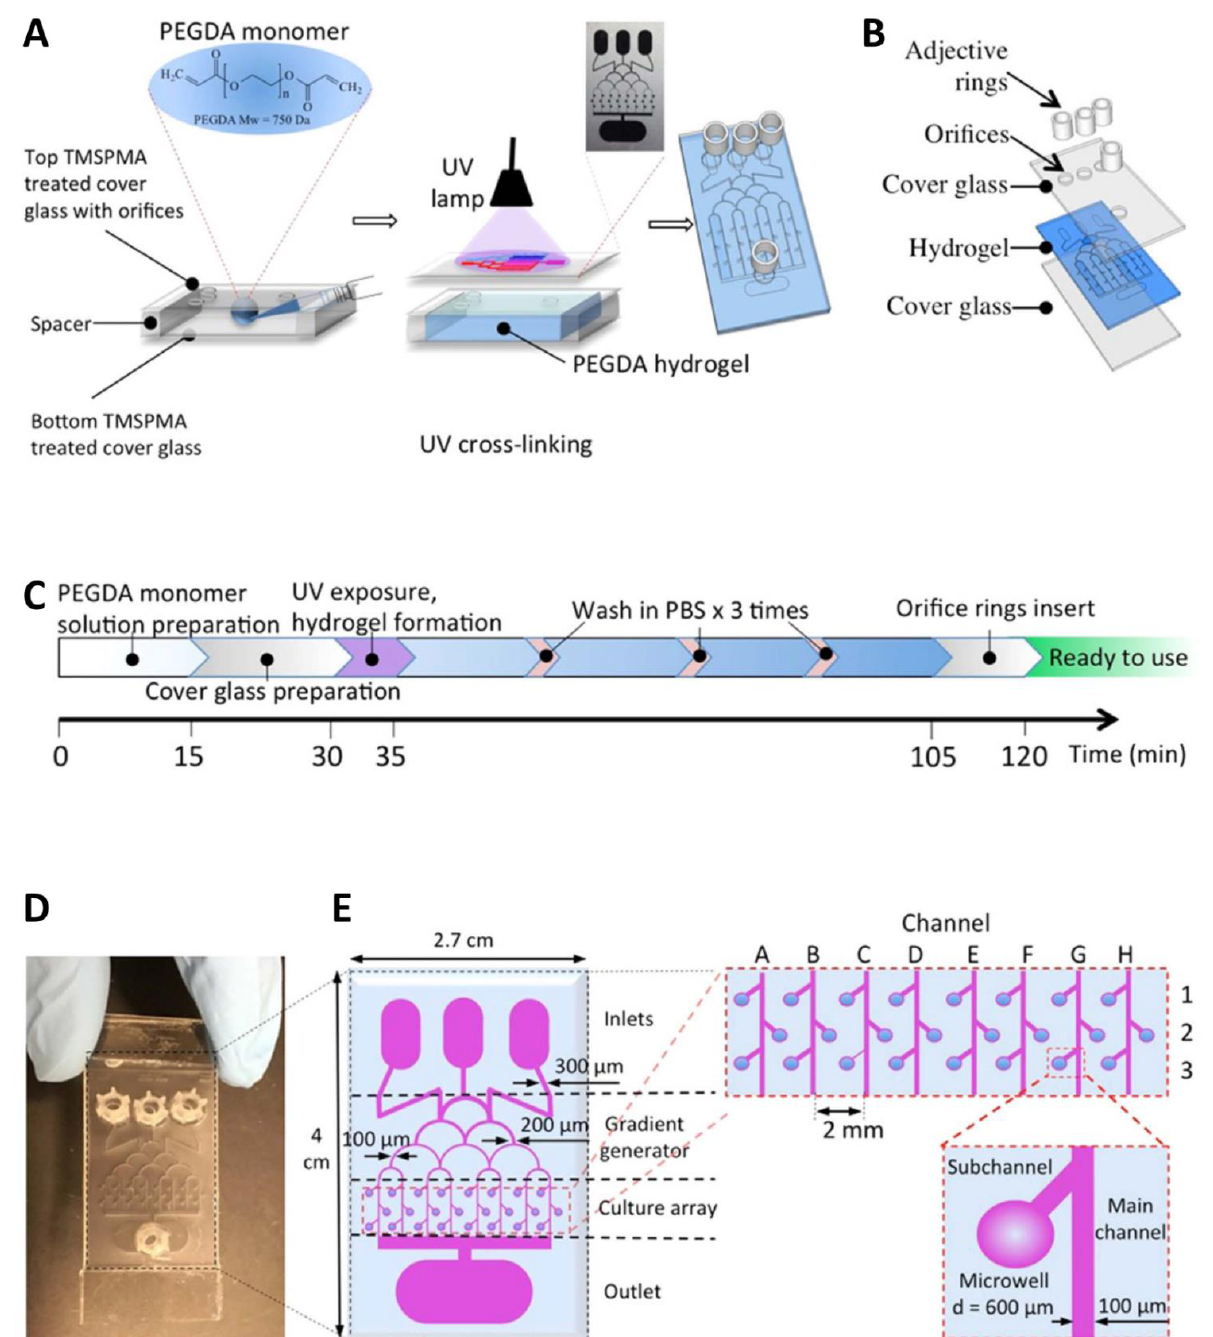
Figure 8. Brain cancer chip design and preparation. ( A ) Final hydrogel device with microchannels and microwells after adding inlet and outlet reservoirs on top of the inlet and outlet orifices. ( B ) Schematic of the layers that are assembled during device fabrication. ( C ) Time protocol of the brain cancer chip preparation. ( D ) Photograph of the device from above. ( E ) Christmas tree-shaped channel system (gradient generator) of the brain cancer chip with channels of gradually decreasing width from 300 µm to 100 µm, an array of 24 individual culture chambers, and three inlet reser- voirs and one outlet reservoir. The sub-channels, which link the microwells to the main channel, prevented captured cells from escaping the microwell. Reprinted with permission from Ref. [147]. Copyright 2016 Nature.